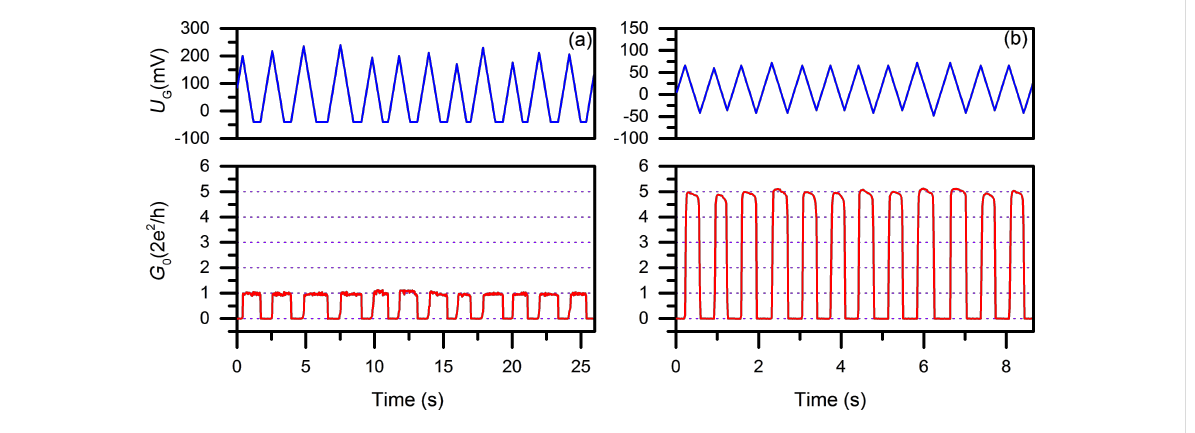
Figure 2: The performance of copper atomic-scale transistors. (a) 0–1 G 0 quantum conductance switching at 0.5 Hz. (b) 0–5 G 0 quantum conduc- tance switching at 1.5